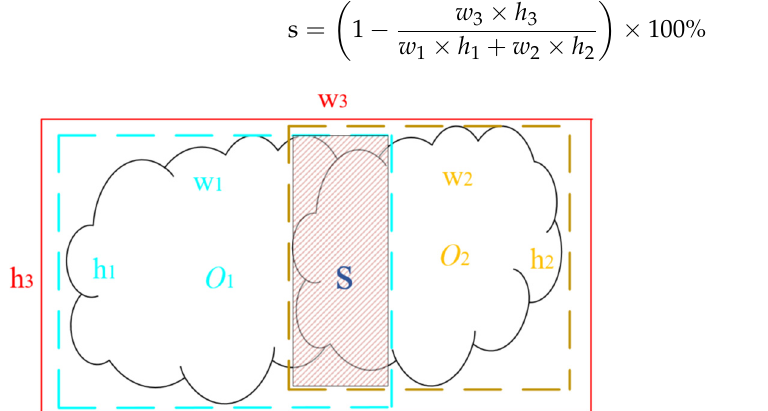
Figure 7. The overlap of the two flower canopies, where, respectively, w1, w2, h1, and h2 are the widths and heights of the two flowers’ plant canopy, w3 and h3 are the total width and height, and O1 and O2 are the central points the two flowers’ plant canopy. S is the overlap area of the two flower’s plant canopy.